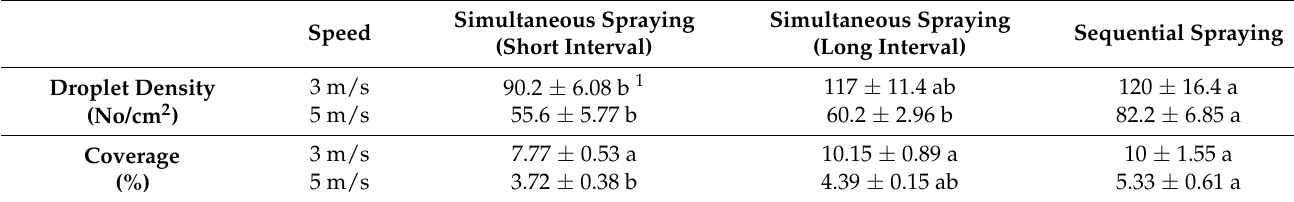
Table 3. Average value of droplet density and coverage in spray overlapping area.